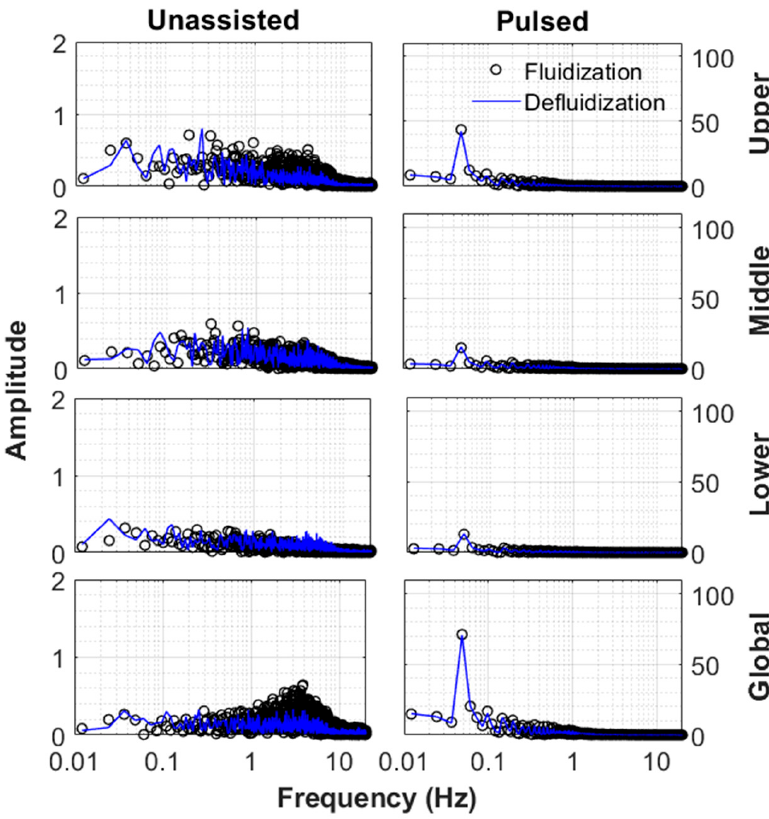
Figure 19. Frequency response of different regions of the bed at 165 mm/s for both unassisted and fluidization.